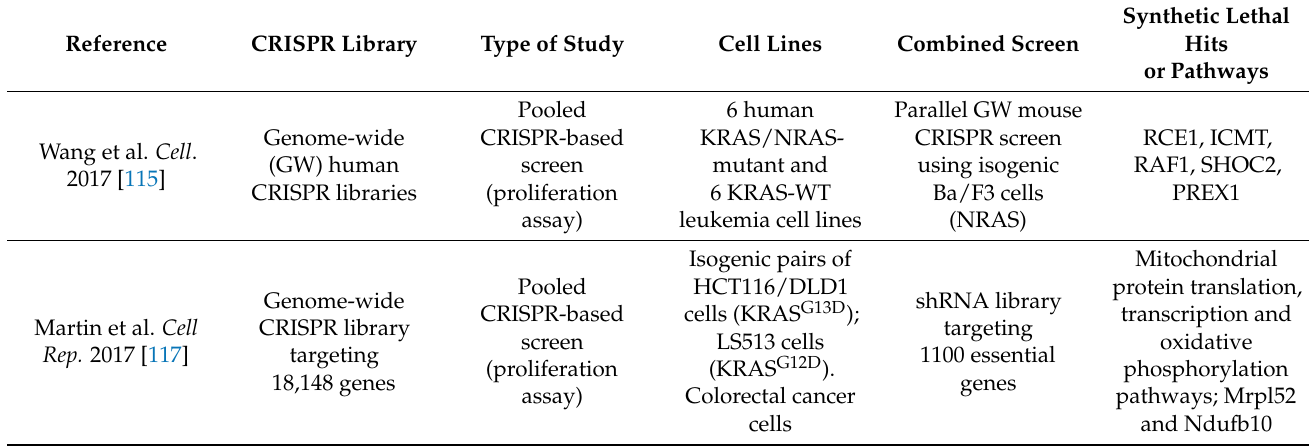
Table 2. KRAS synthetic lethal CRISPR-based functional